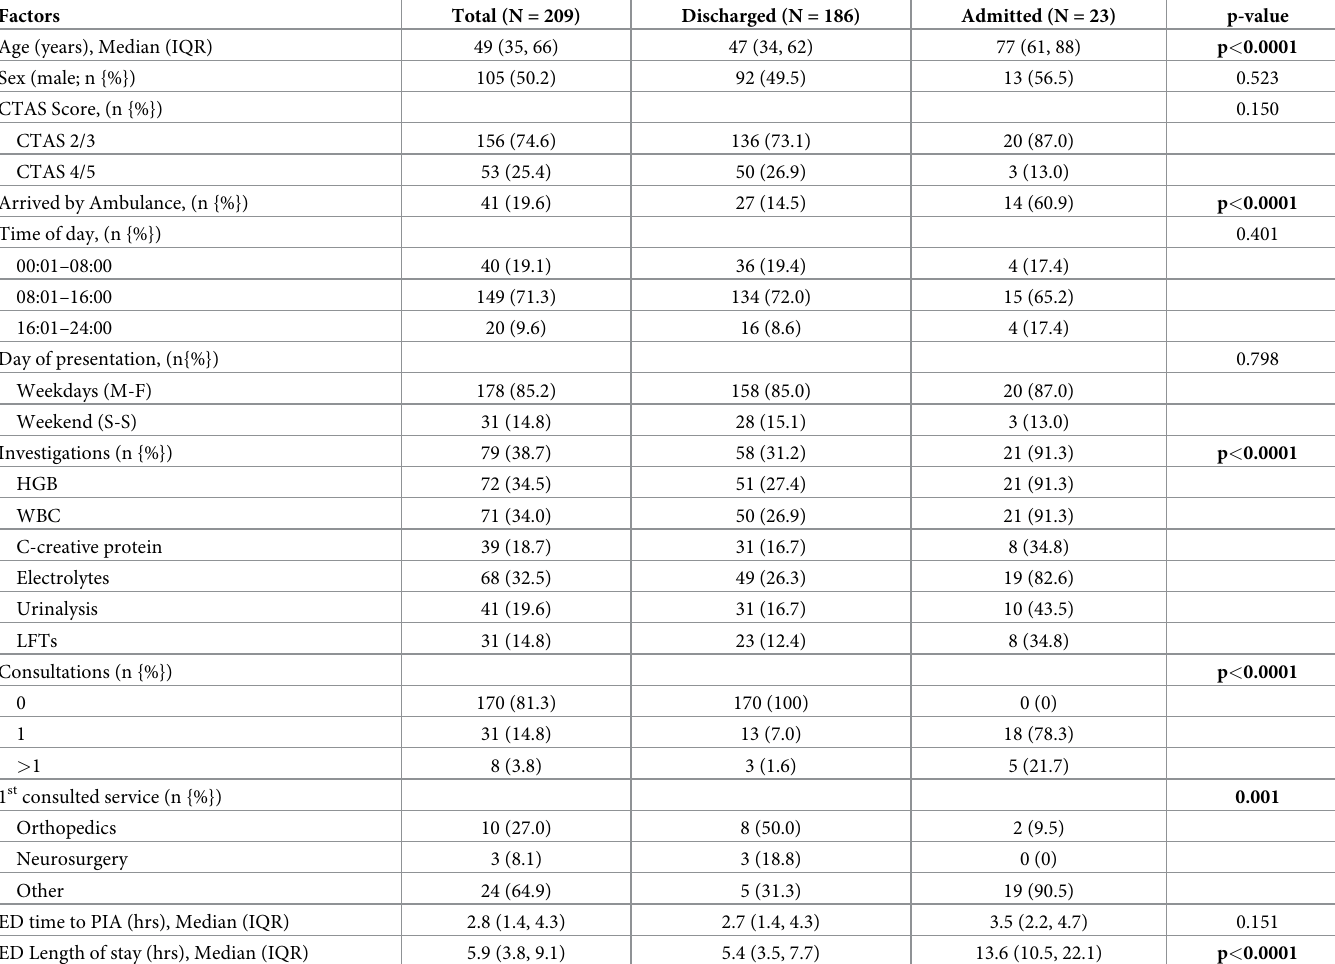
Table 1. Demographic and ED presentation characteristics of patients with acuity low back pain presenting to Canadian emergency department, sub-grouped by disposition